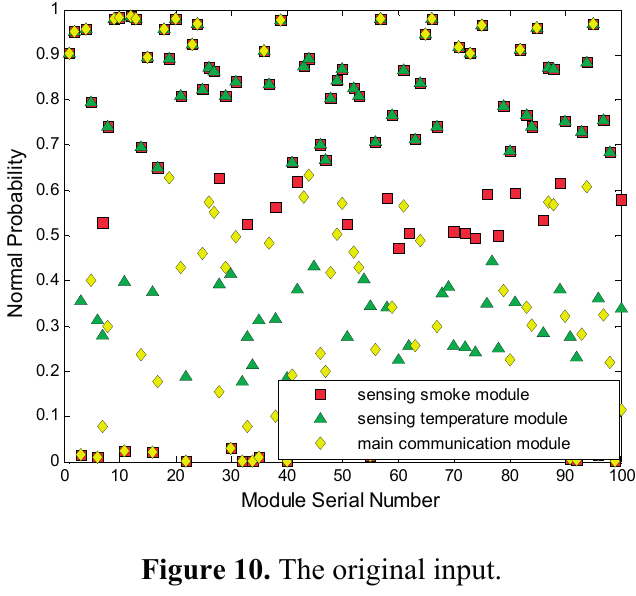
Figure 10. The original input.